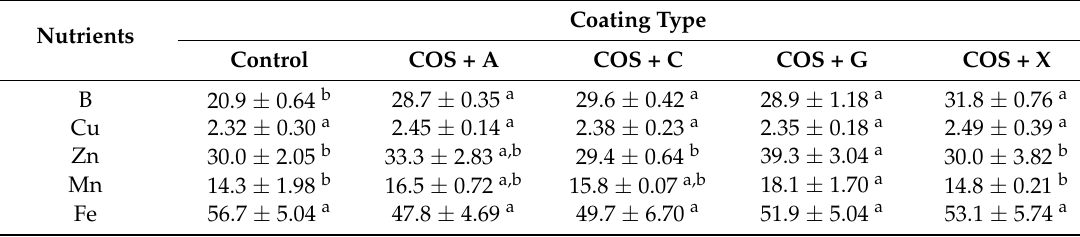
Table 3. Effects of COS coating combined with selected ionic polymers on micronutrients concentrations (mg kg − 1 DW) in the leaves of Ornithogalum saundersiae